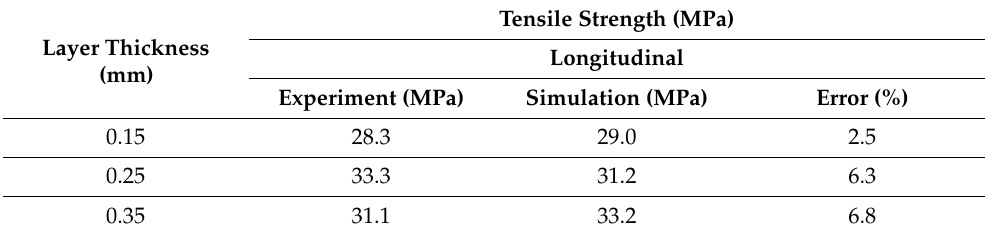
Table 6. Modelling results for the layer thickness set (Method 1).